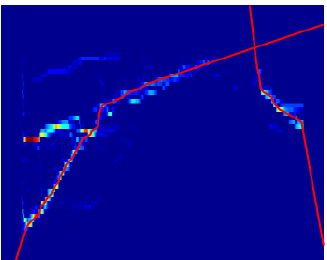
Figure 16. Radon transform application